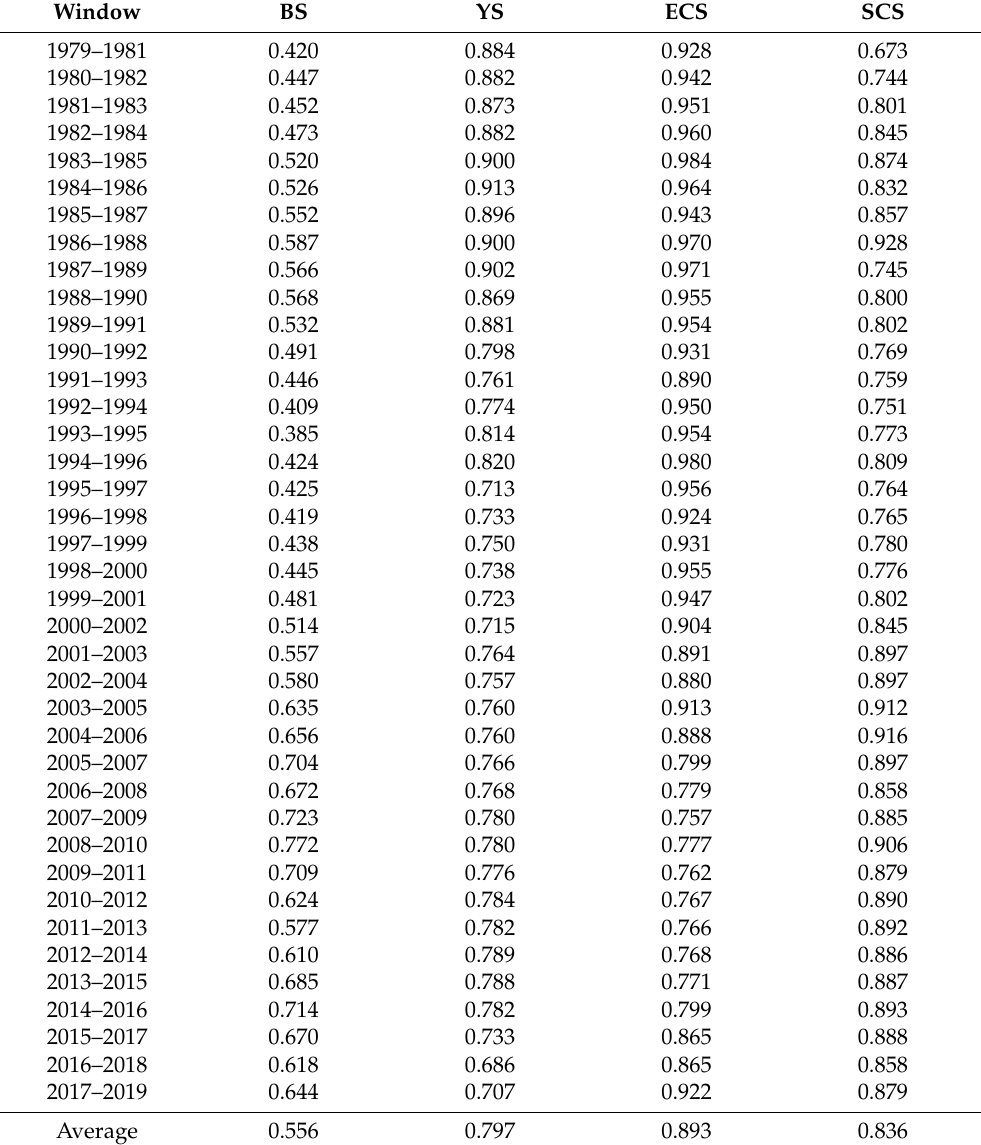
Table 2. Results of window-DEA, per sea. (The Bohai Sea (BS), Yellow Sea (YS), East China Sea (ECS), and South China Sea (SCS)). Window BS YS ECS